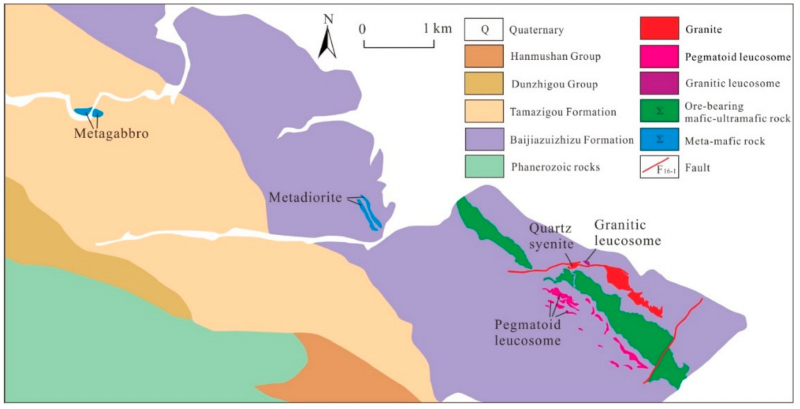
Figure 2. Geologic map of the Jinchuan mineral